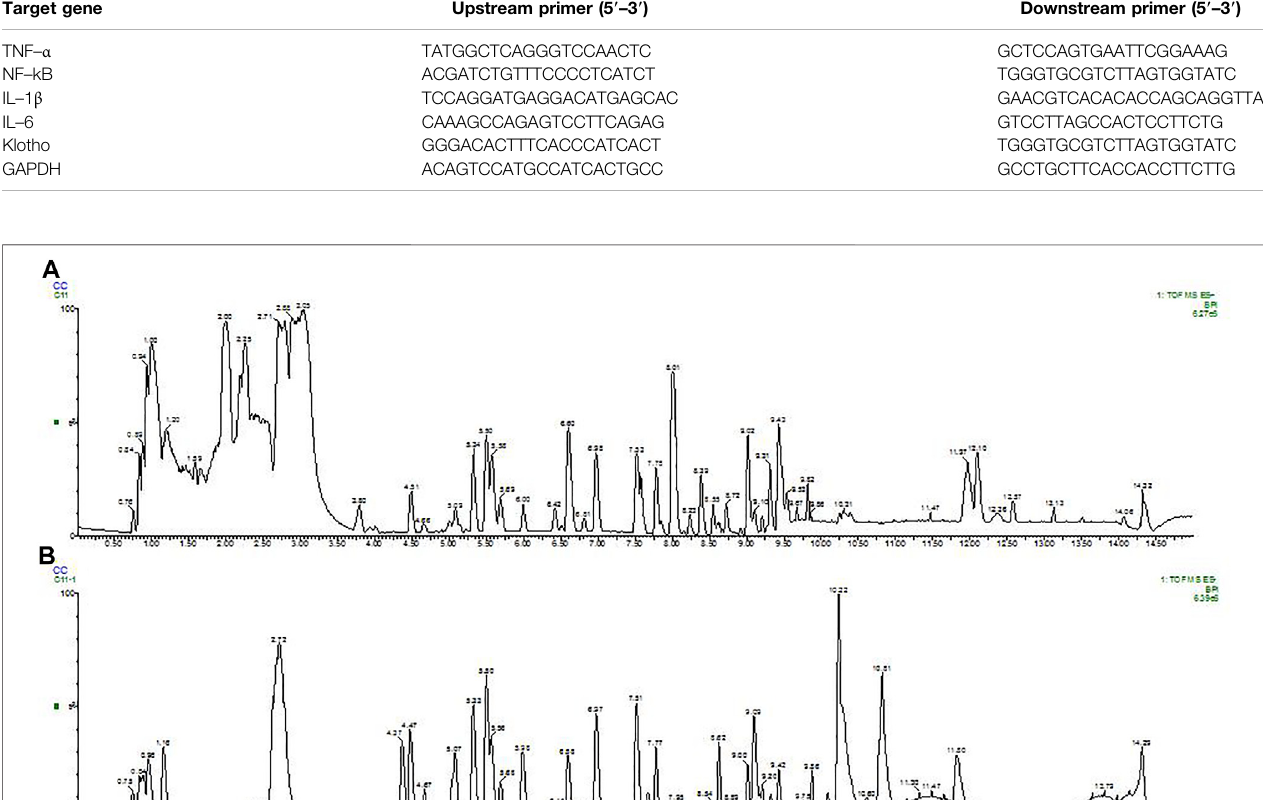
Frontiers in Pharmacology |